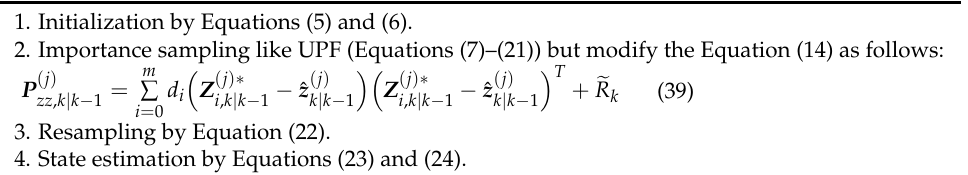
Table 2. Algorithm of the proposed robust